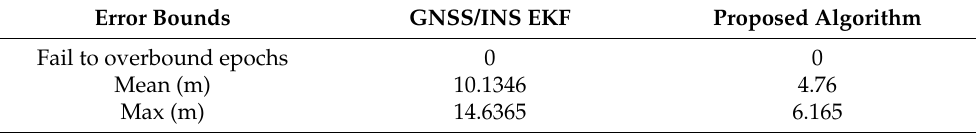
Figure 15. The error bounds and horizontal error of the EKF and the proposed algorithm in case one. ( a ) The error bounds and horizontal error of the EKF. ( b ) The error bounds and horizontal error of the proposed algorithm. Table 4. The error bounds of the EKF and proposed algorithm during the fault period.